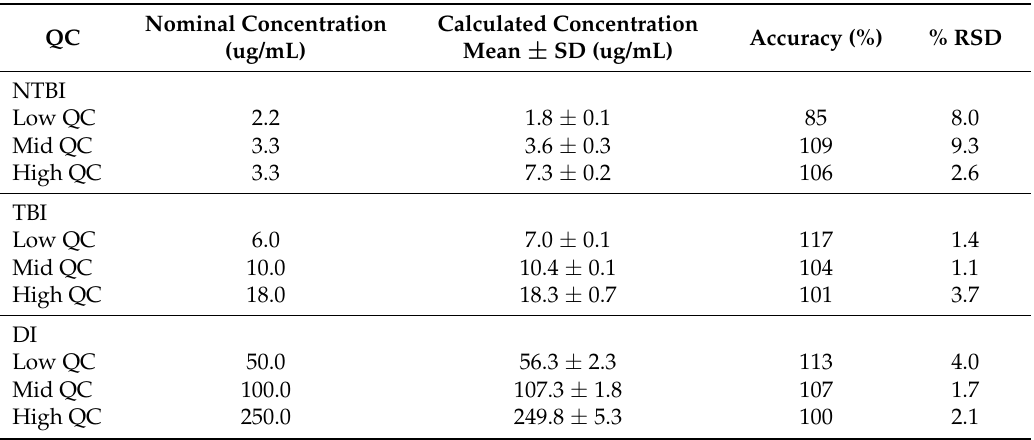
Table 2. Accuracy and precision data of Ultrafiltration